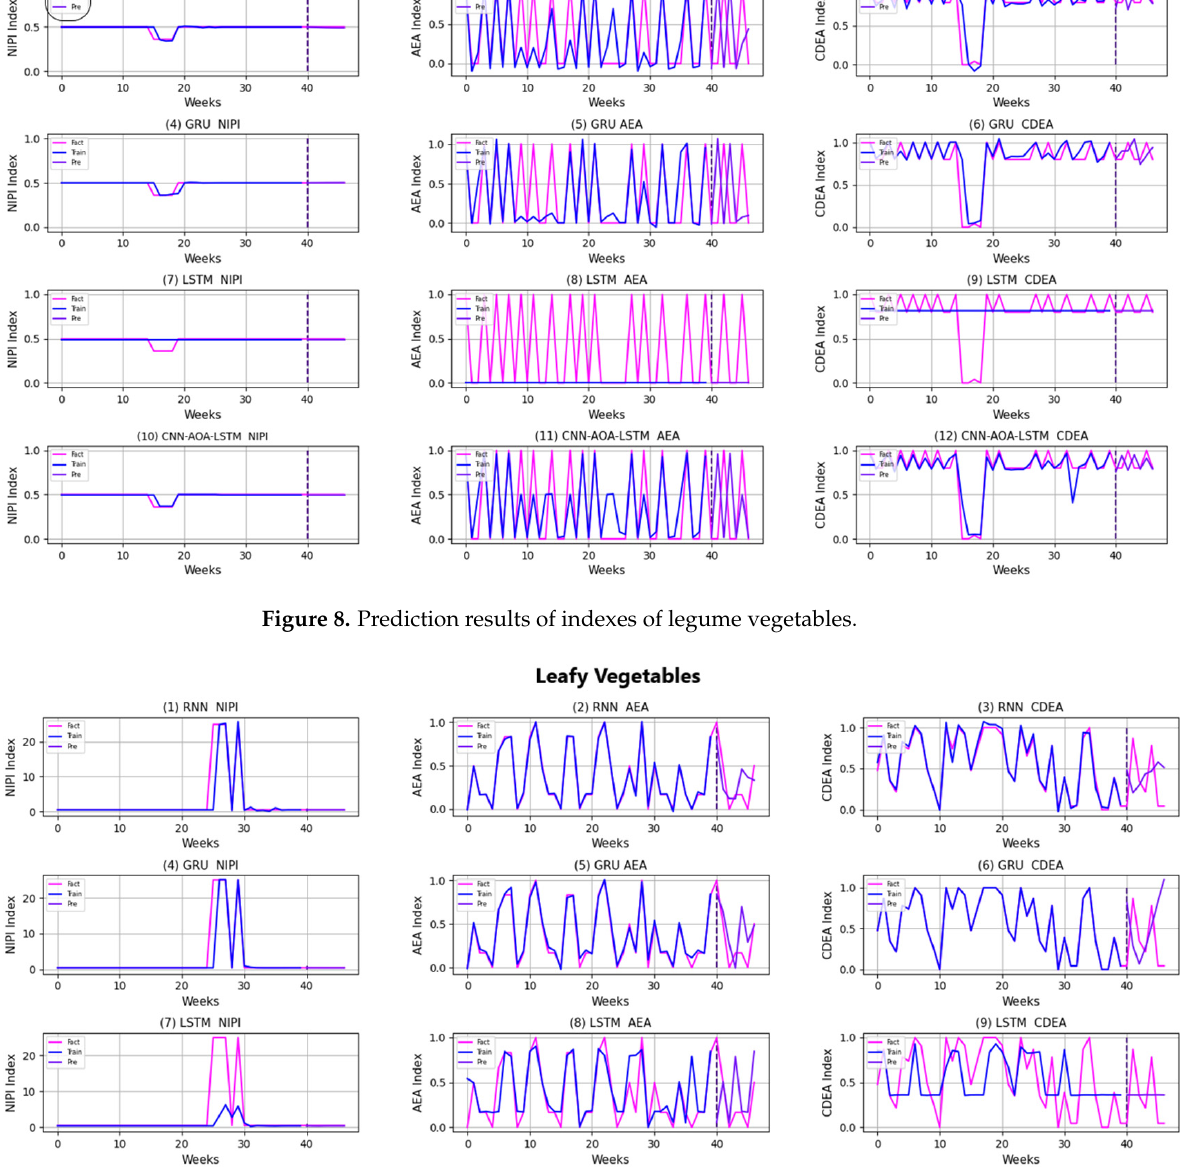
Figure 10. Prediction results of indexes of solanaceous vegetables.